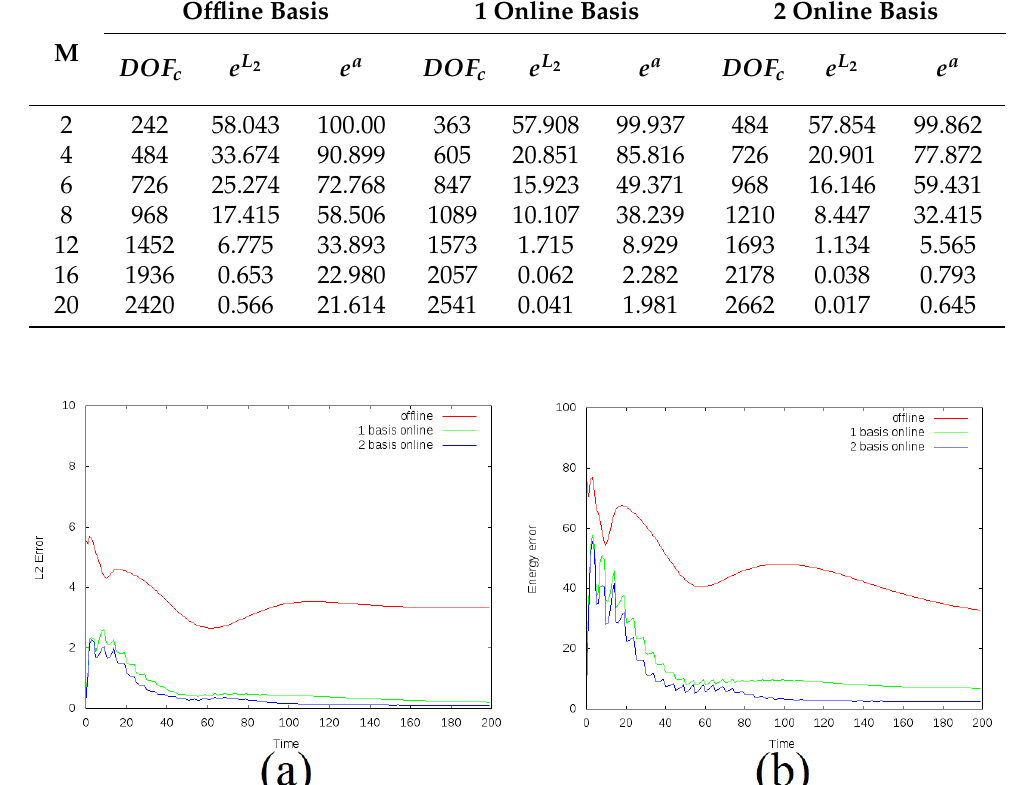
Figure 10. Numerical results for Test 3 . Error comparison between offline approach using 12 offline basis and online approach using 1 and 2 online basis. ( a ): L 2 error. ( b ): energy